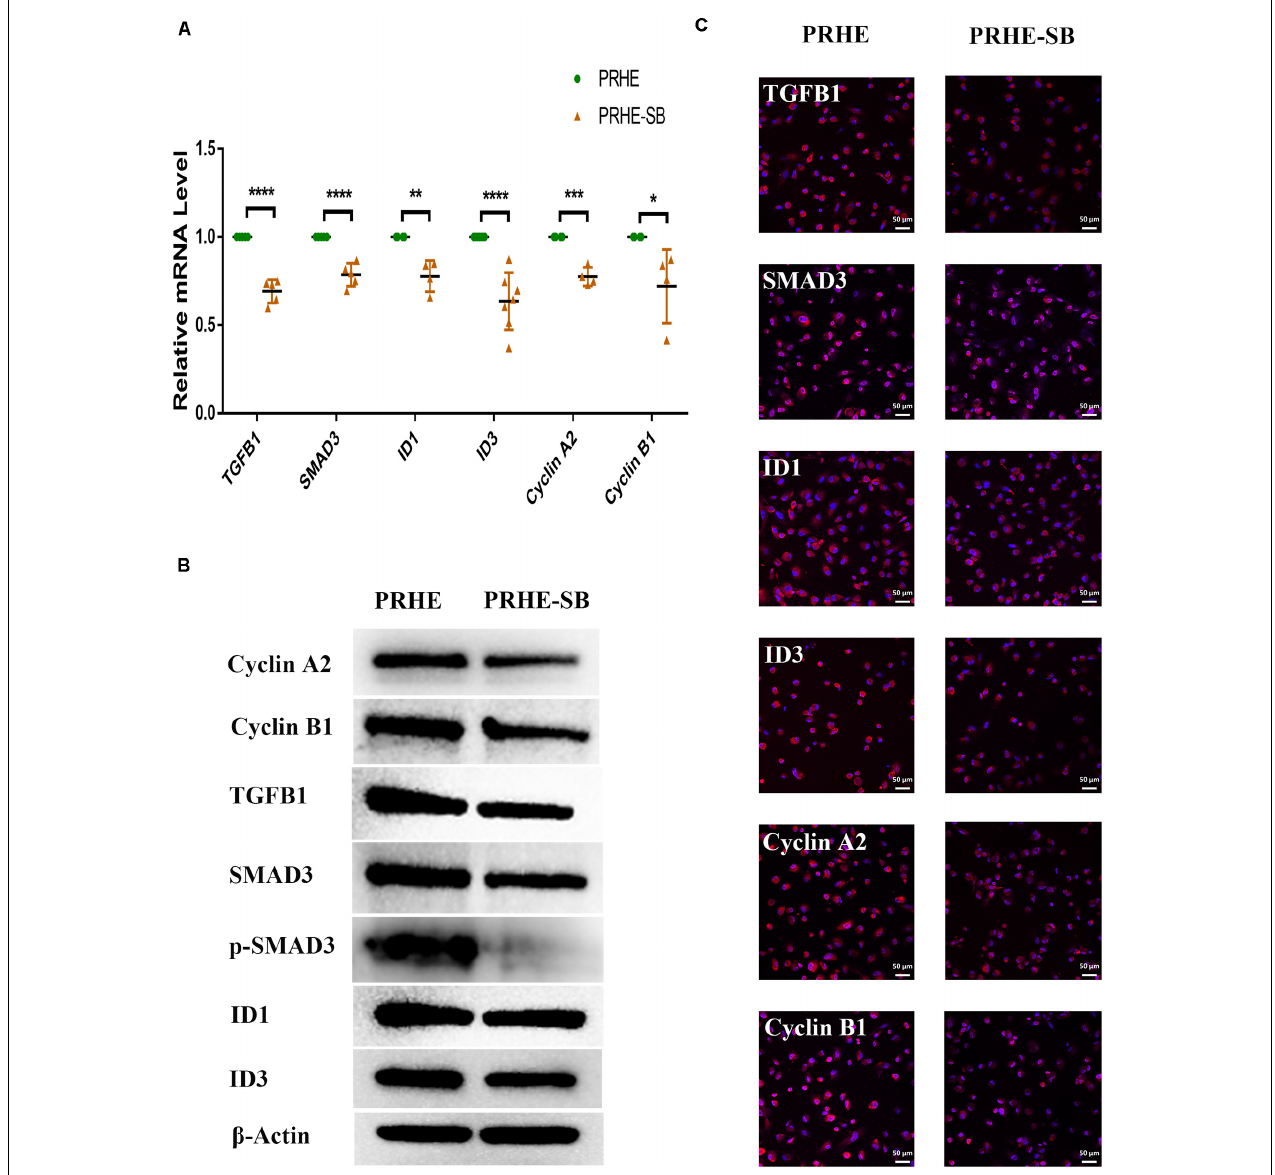
FIGURE 11 | Inhibition of the TGF β pathway upregulated senescence-related positive markers and downregulated senescence-related negative markers in ESCs-cocultured premature senescent RPE cells. (A) Expression of the TGF β pathway and cellular senescence-related markers in the PRHE and PRHE-SB groups, as assessed by RT-qPCR ( n ≥ 3 biological repeats). (B) Results of the TGF β pathway and cellular senescence-related markers in the PRHE and PRHE-SB groups as determined by western blotting. β -Actin was used as the internal reference. (C) The expression levels of the TGF β pathway and cellular senescence-related markers in the PRHE and PRHE-SB groups as determined by immunofluorescent staining. Scale bar, 50 µ m. Data are presented as the mean ± SD. ∗ P < 0.05; ∗∗ P < 0.01; ∗∗∗ P < 0.001; ∗∗∗∗ P < 0.0001. PRHE-SB: RPE cells from passages 4 to 6 treated with 400 µ M H 2 O 2 and then cocultured with ESCs with 10 µ M